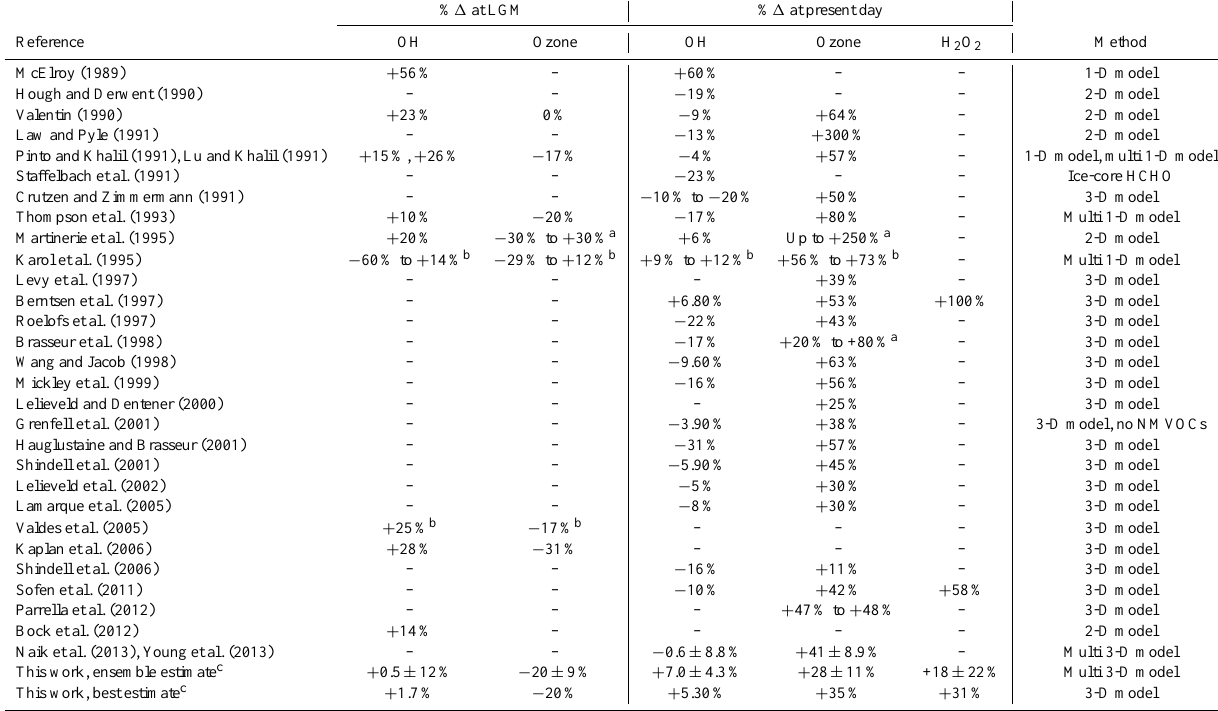
Table 1. Percentage changes in tropospheric burdens of OH, ozone and H 2 O 2 , relative to the preindustrial, compiled from the